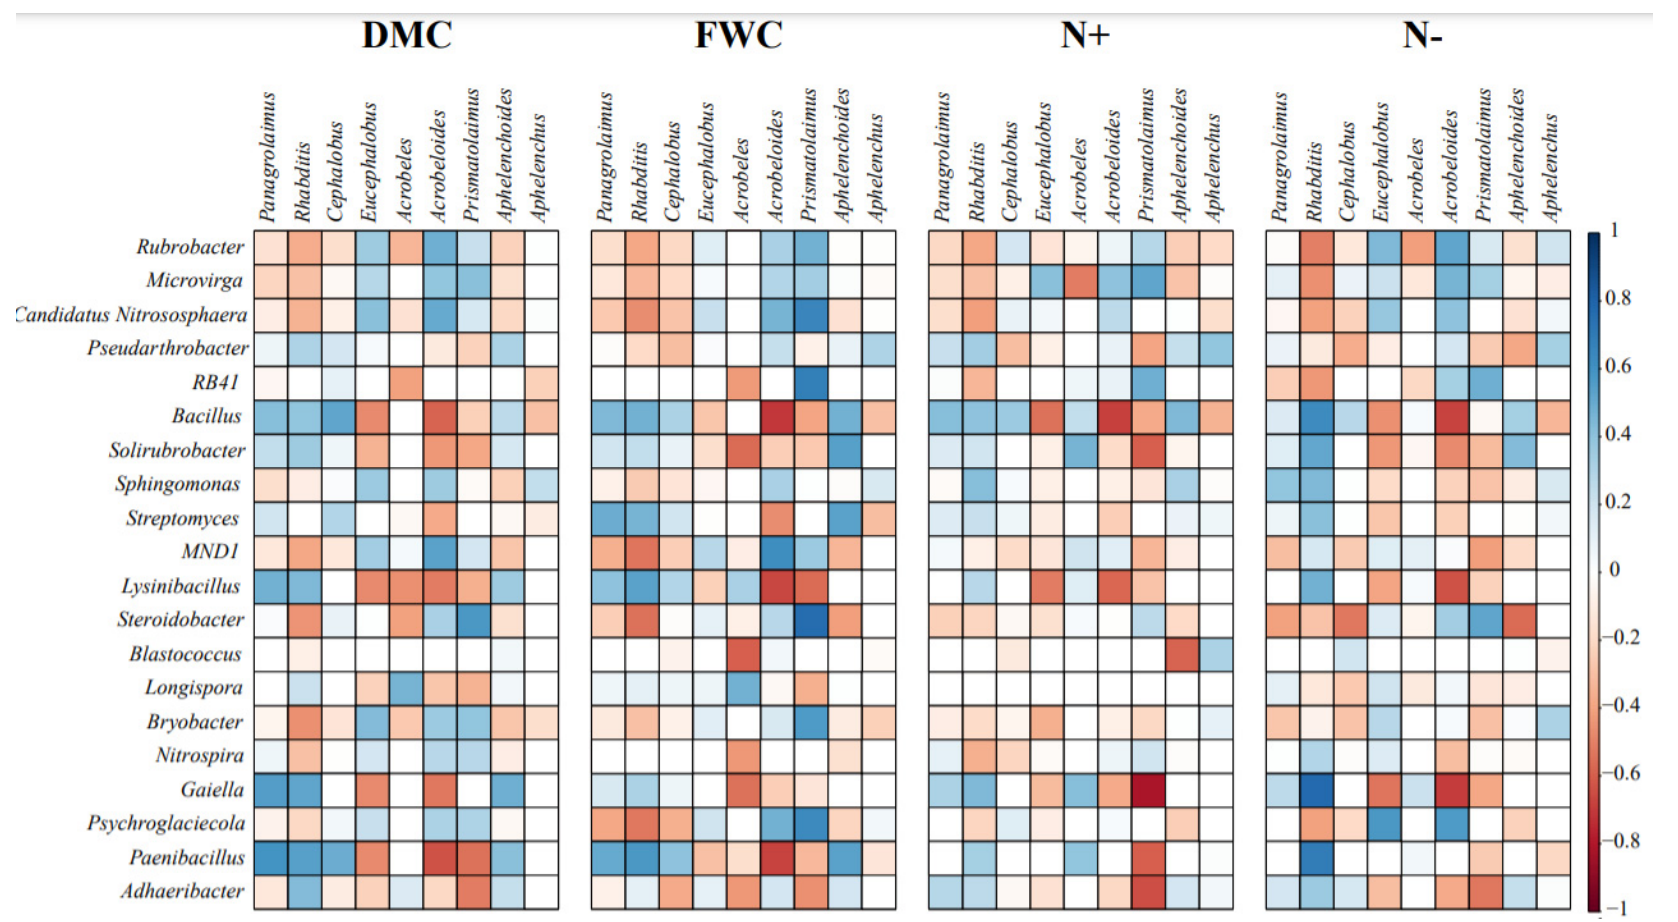
Figure 3. Heat map of Spearman rank correlation coefficients between nematode and bacterial and archaeal genera collected from almond orchard soil in 2016 and 2017 where treatments applied were either DMC = Dairy manure compost, FWC = Food waste compost, N+ = nitrogen fertilizer, or N- = unamended control. Only those relationships statistically significant at the p < 0.05 level are shown. Darker colors indicated stronger correlations, with blue indicating positive correlations and red negative.